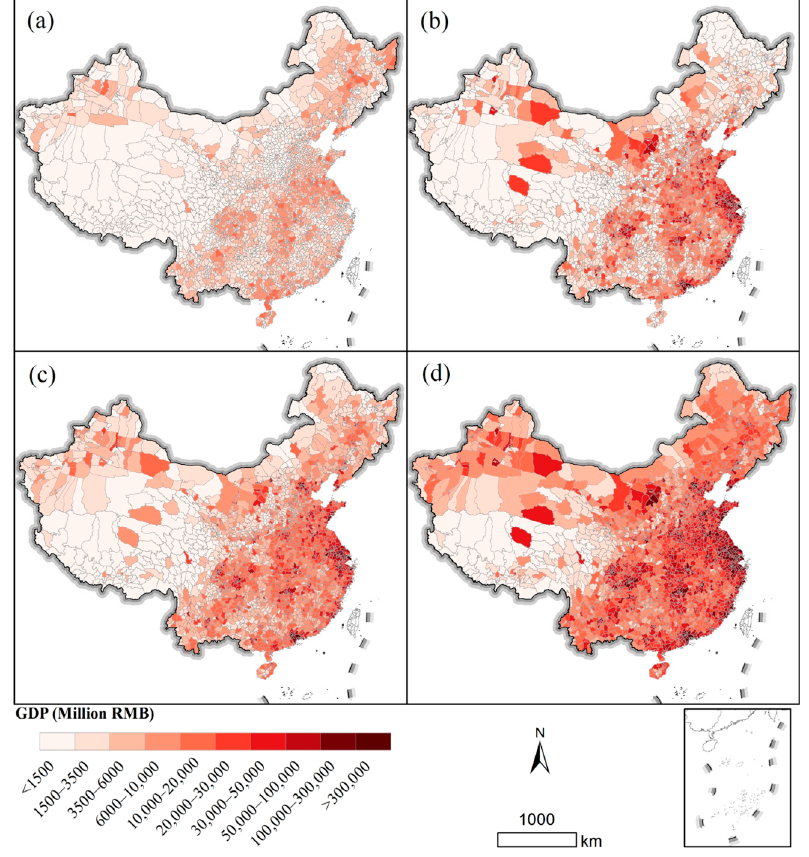
Figure 1. County-level GDP data in mainland China: ( a ) primary sector, ( b ) secondary sector, ( c ) tertiary sector, ( d ) total GDP.